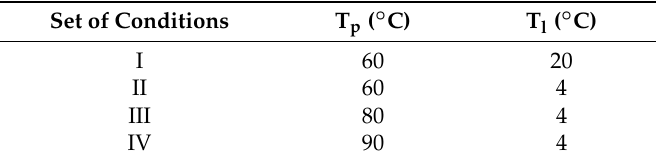
Table 2. The overview of programming conditions for the shape memory investigation. Set of